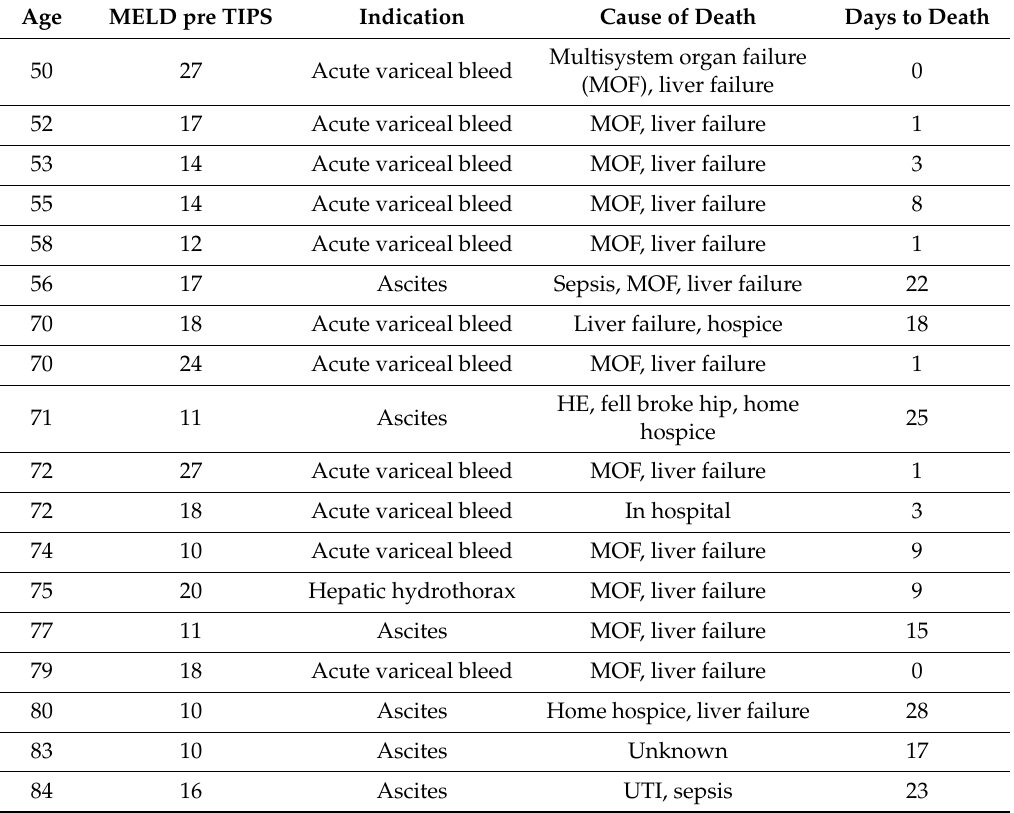
Table 4. Characteristics of patients that died within 30 d of TIPS.